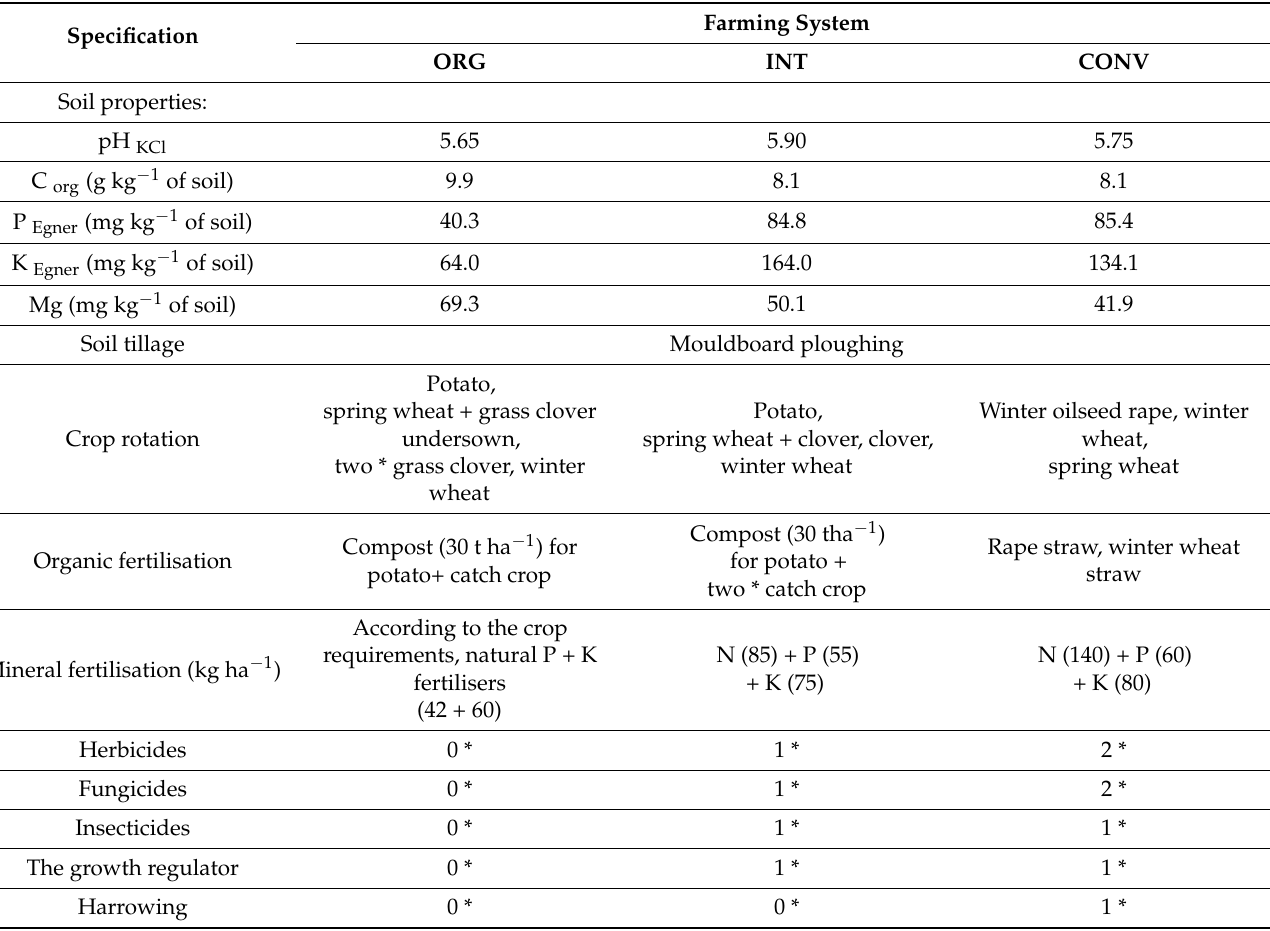
Table 4. Soil chemical properties and agrotechnical treatments used in the different farming